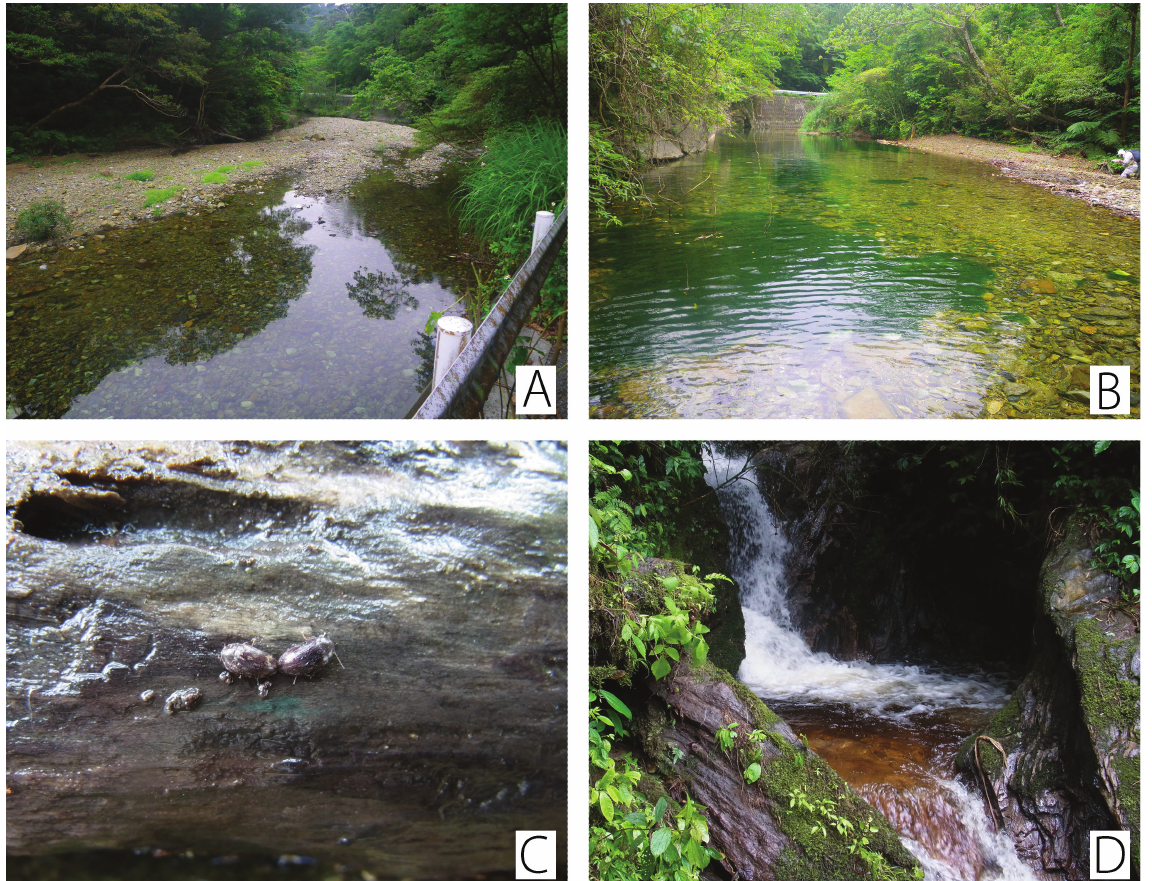
Fig. 5. Habitat of Caccothryptus spp. A – B . Genkagawa, Nago-shi, Okinawa, type locality of C . orion sp. nov. Photographs by Mr Mori. C – D . Ban Khoang, Vietnam, copulating individuals of C . malickyi Hernando & Ribera, 2014 under surface of water-logged wood (C) and their environment (D). Photographs by